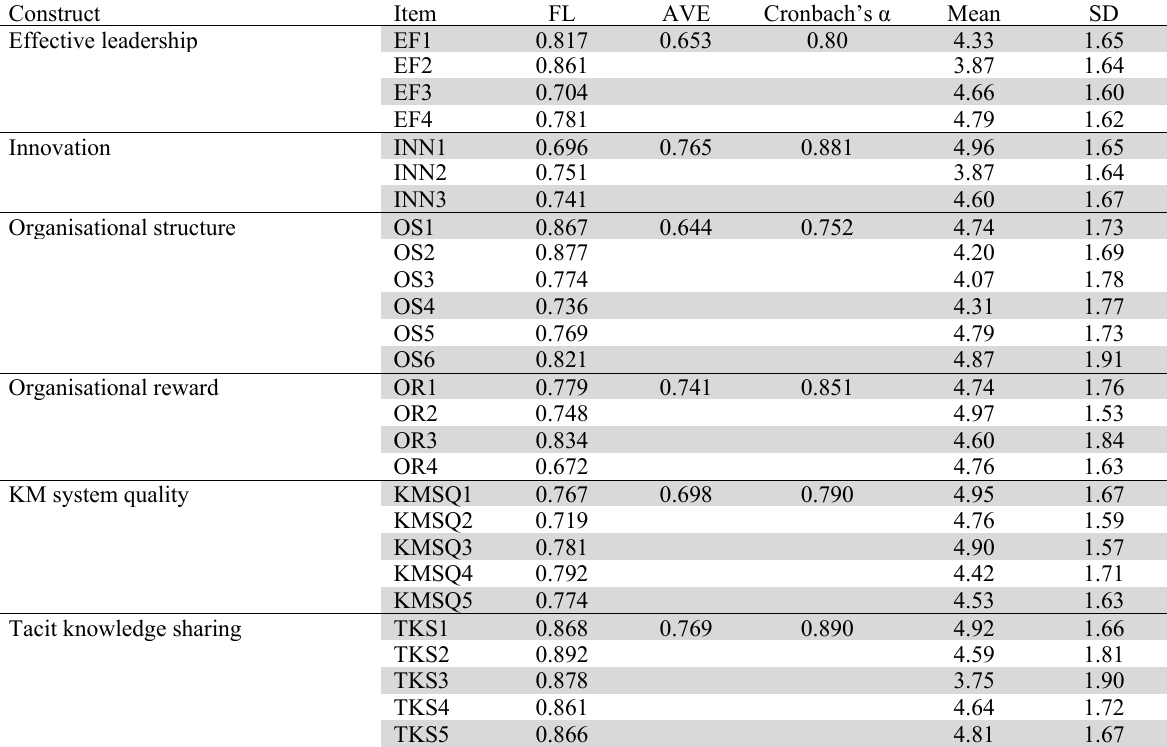
Reliability statistics